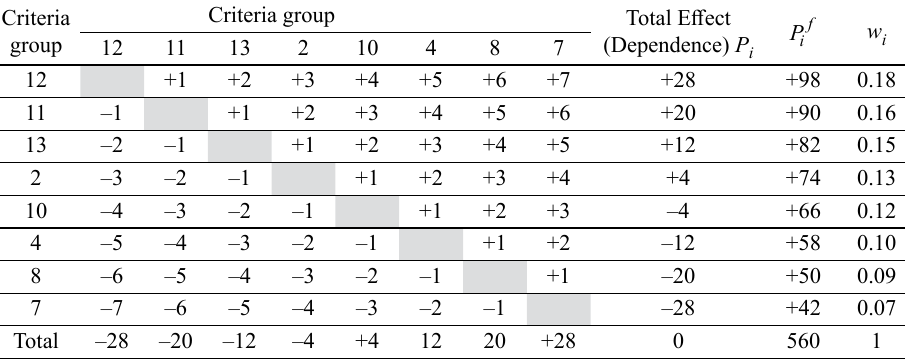
Table 10. The calculation of the criteria weights by FARE method Criteria Criteria group